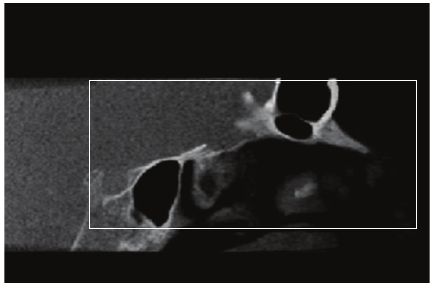
Figure 6: Multi-planar reconstruction (MPR) of the dedicated orbital volume (DV). Sagittal view.